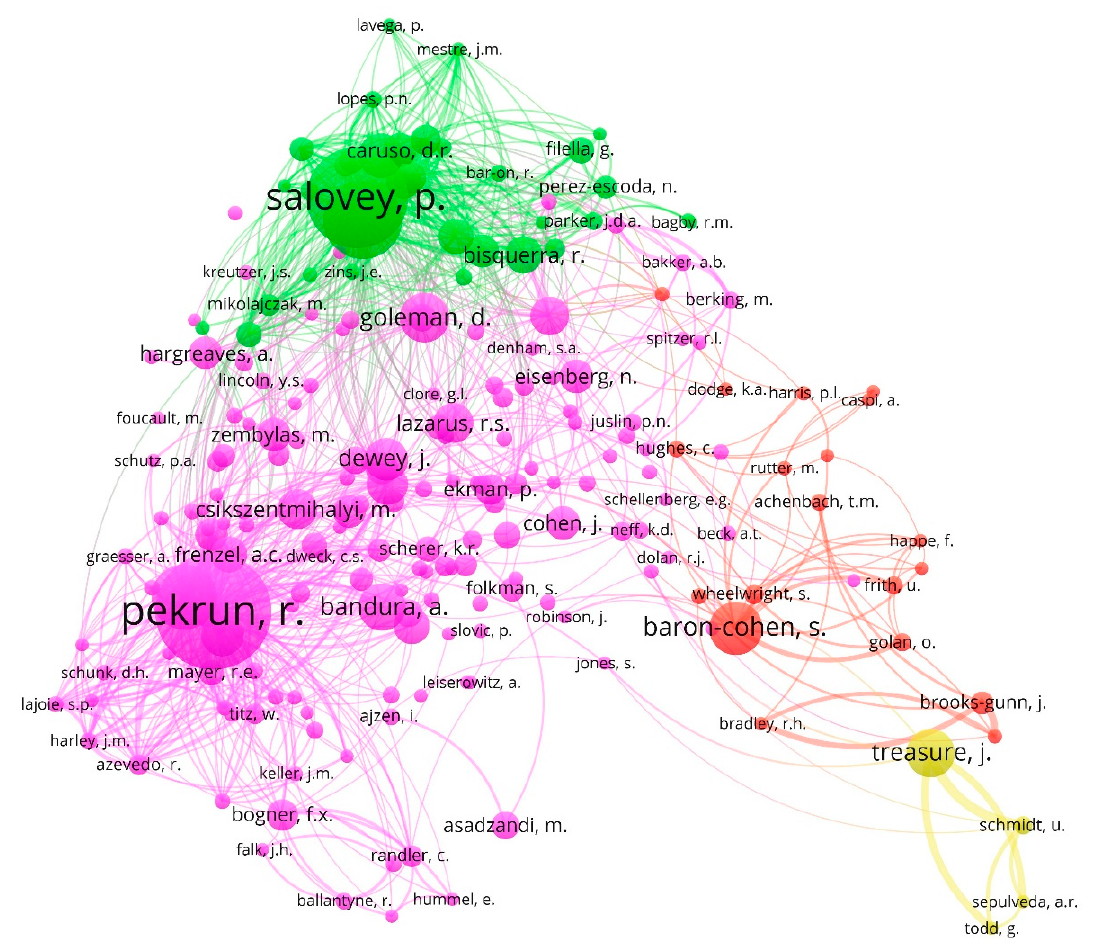
Figure 4. Network of authors based on co-citation method (1917–2020).